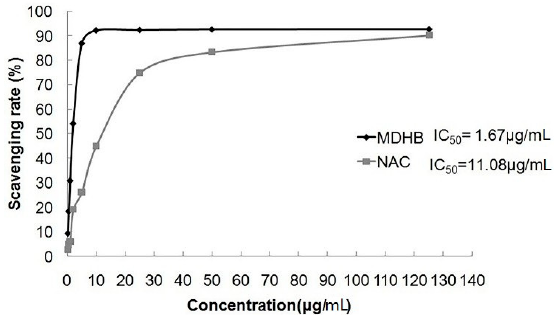
Figure 3. The scavenging rate of MDHB on DPPH free radical. Data are expressed as the mean ± S.E.M.